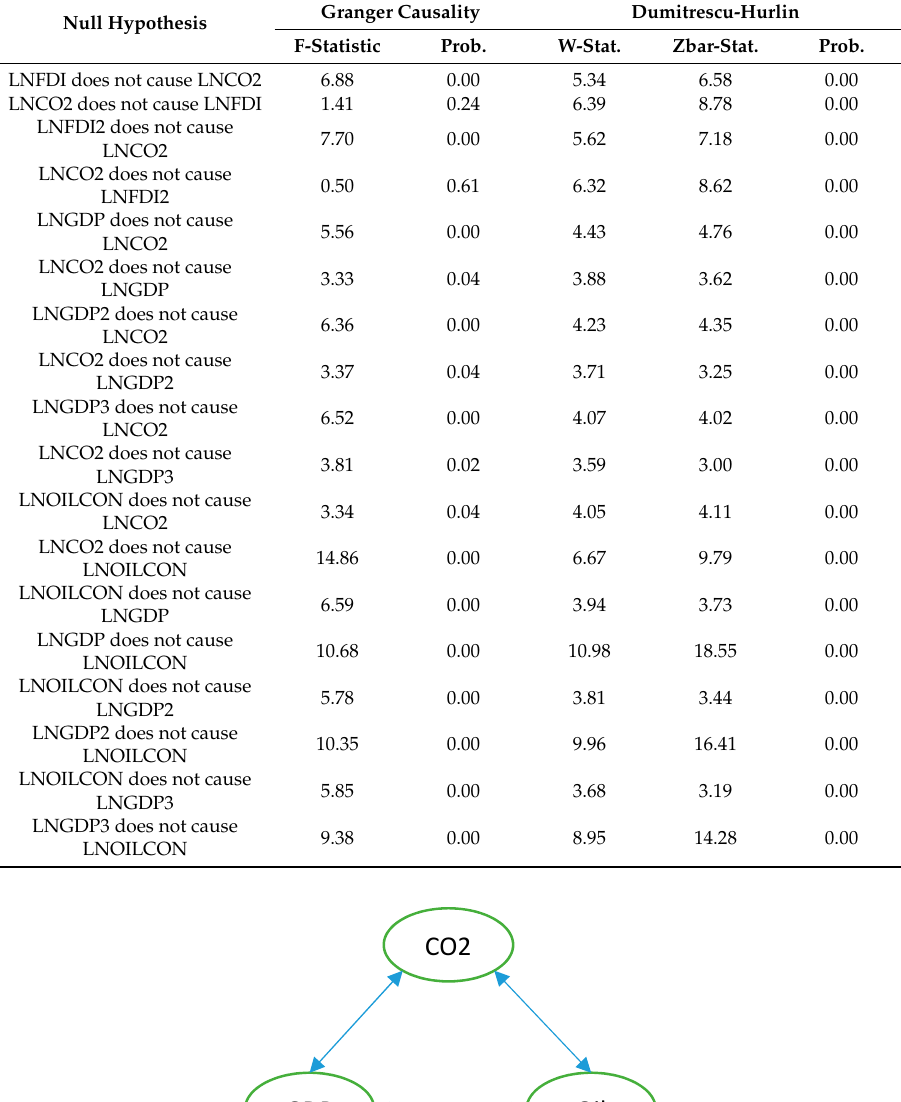
Table 7. Causality test.